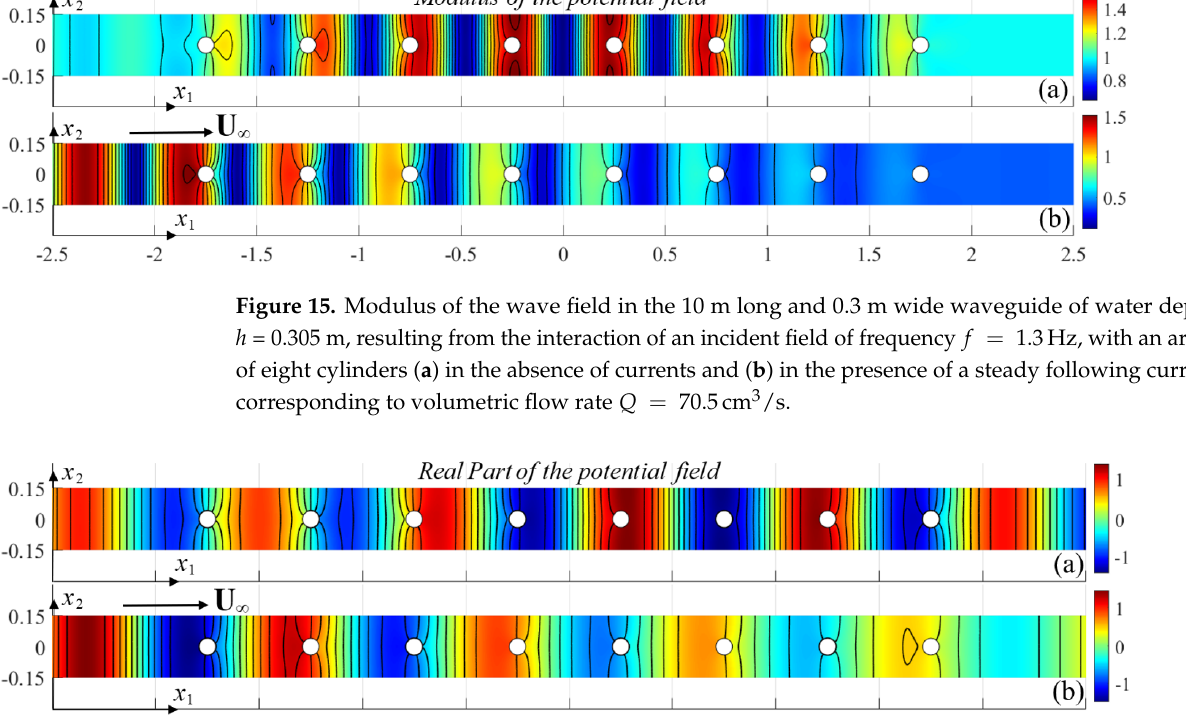
Figure 16. Real part of the wave field in the 10 m long and 0.3 m wide waveguide of water depth h = 0.305 m, resulting from the interaction of an incident field of frequency f = 1.3Hz, with an array of eight cylinders ( a ) in the absence of currents and ( b ) in the presence of a steady following current corresponding to volumetric flow rate Q = 70.5cm 3